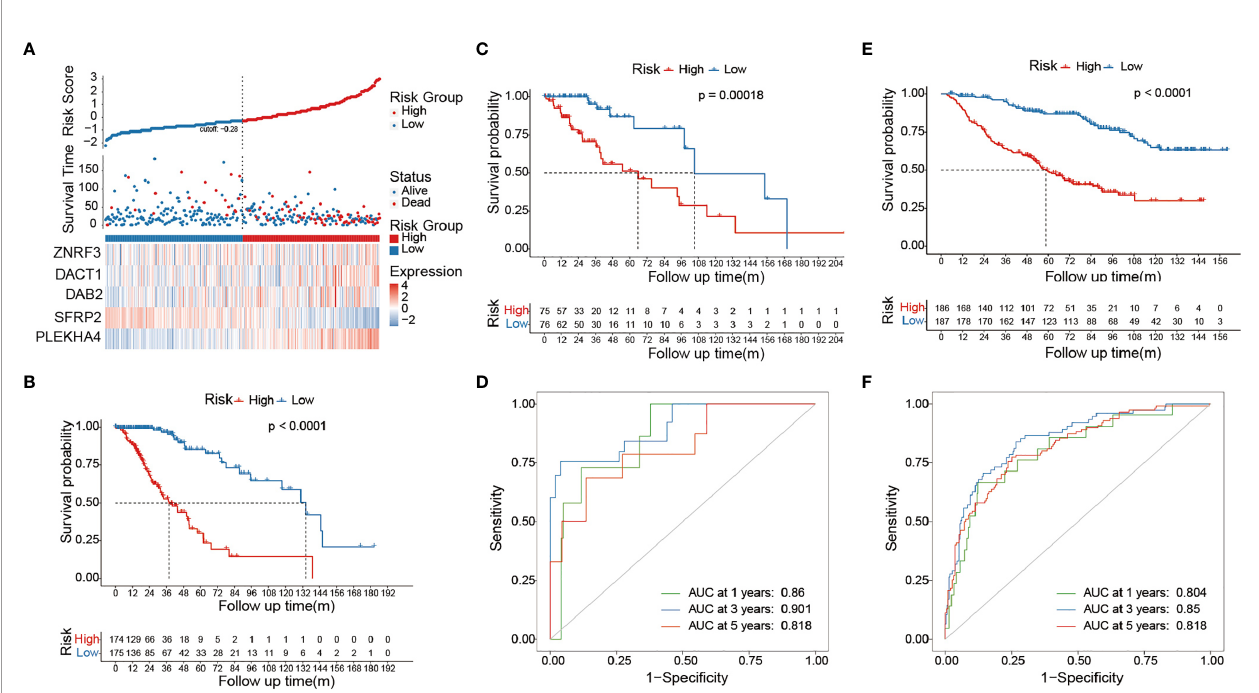
FIGURE 6 | Risk score system predicts survival of LGG patients. (A) The ranked risk score of 357 LGG samples is shown at the top. Dot plot in the middle represents the survival time of the corresponding sample. Heat map shows the Log2-transformed expression of each prioritized gene. The vertical dashed line in the middle classi fi es LGG samples into low risk (blue) and high risk (red). (B) The Kaplan – Meier curve at the bottom showed survival difference between low-risk and high-risk groups. The Cox model was constructed on 357 LGG samples in the training set. The Cox model showed signi fi cant survival difference between the low- risk and high-risk groups. The p-value was calculated by the log-rank test. The validation was carried out on 153 and 408 LGG samples from the TCGA testing set (C, D) and CGGA dataset (E, F) . The AUROC curve demonstrates the performance of our model in predicting the survival of LGG patients.